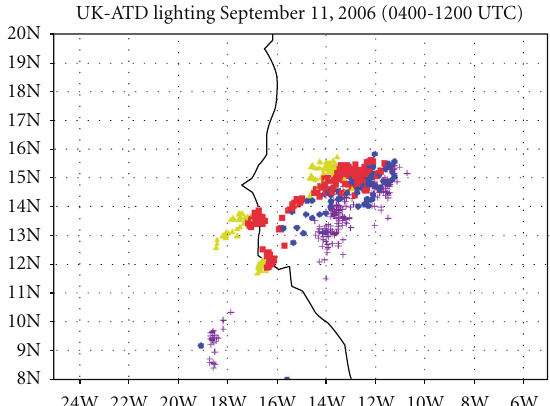
Figure 10: An image of cloud-to-ground lightning flashes on 11 September 2006 between 0400 and 1200UTC. Purple crosses are for CG flashes from 0400 to 0600 UTC; blue circles are for flashes from 0600 to 0800 UTC; red squares are for flashes from 0800 to 1000 UTC; yellow triangles are for flashes from 1000 to 1200 UTC.